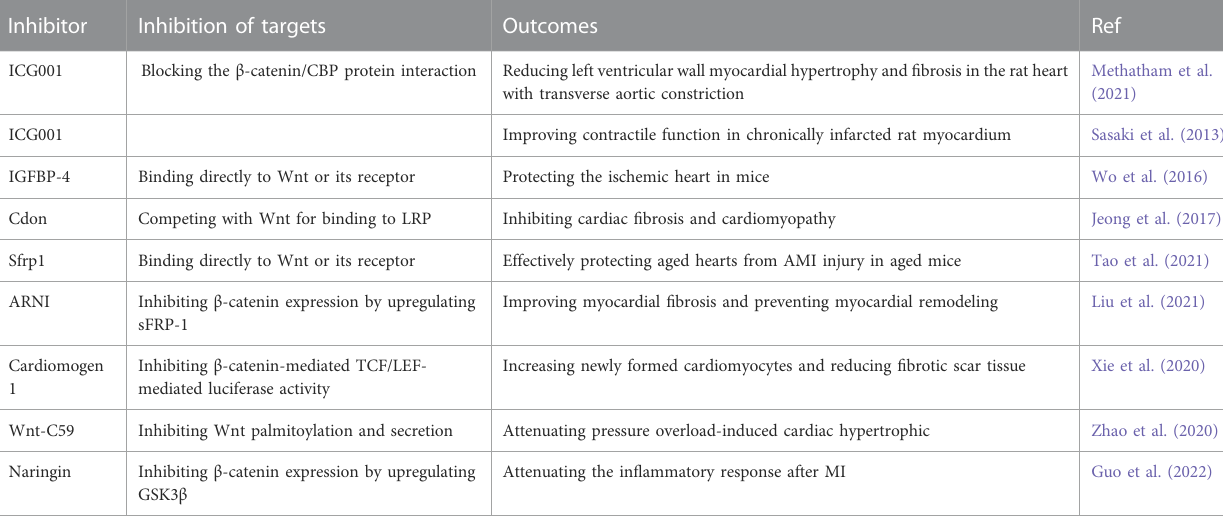
TABLE 2 Several Wnt/ β -catenin pathway inhibitors for cardiac diseases. Inhibitor Inhibition of